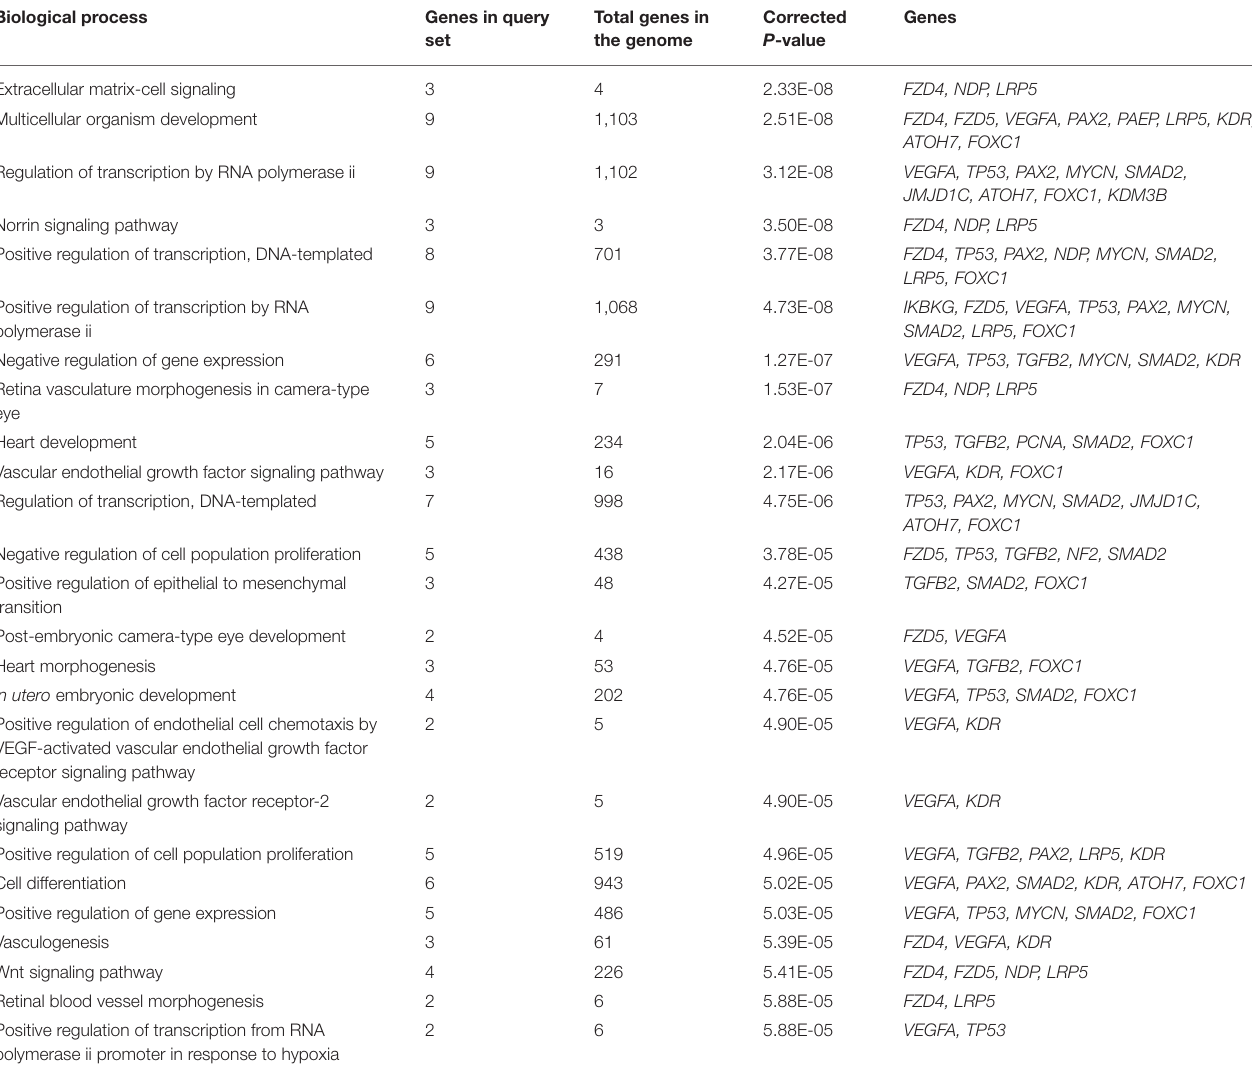
TABLE 1 | Top 15 enriched Gene Ontology (GO) biological process terms assigned to the text mining genes. Biological process Genes in query